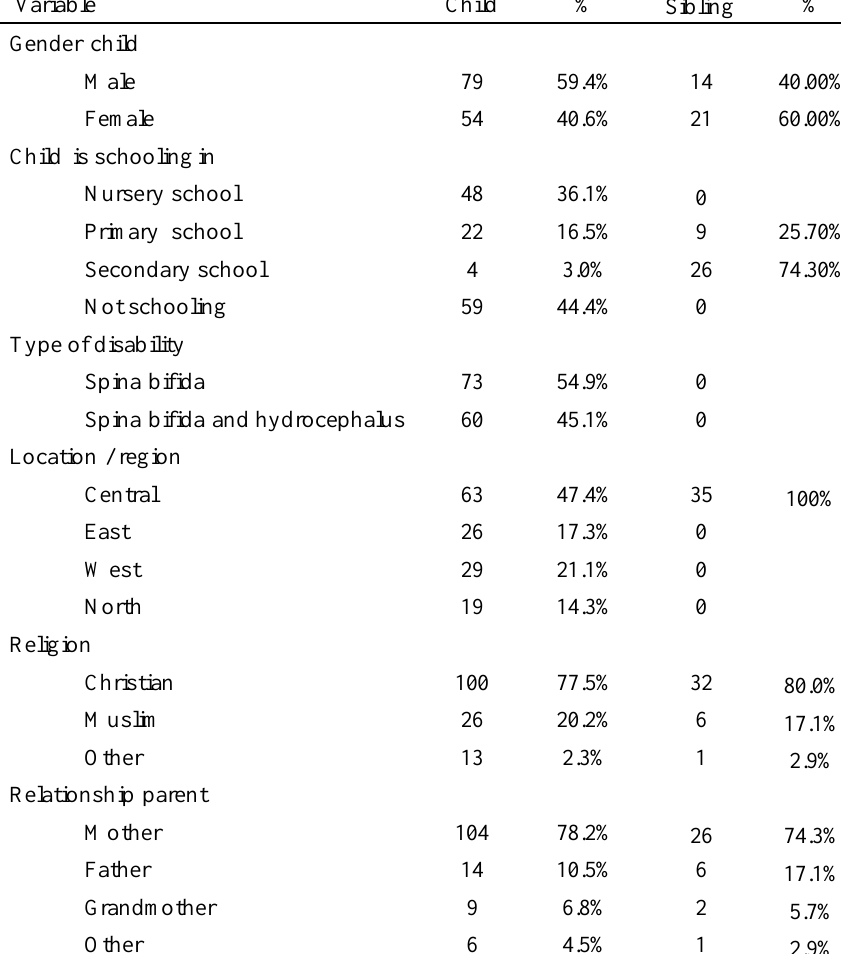
Demographic Characteristics (N=133 children with spina bifida, N=35 siblings)